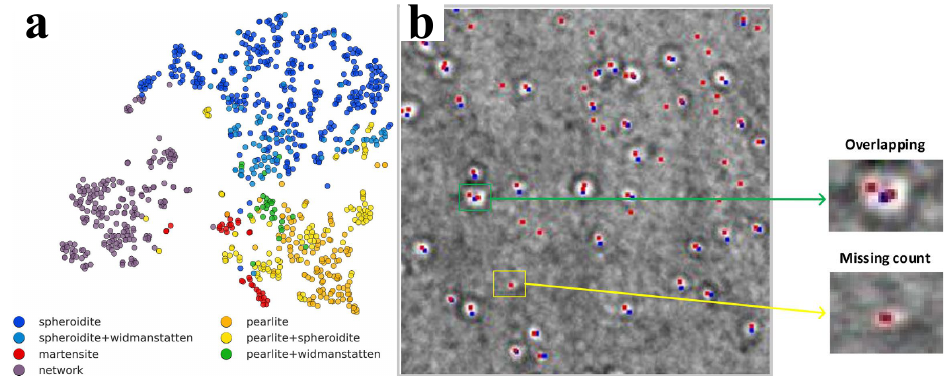
Figure 3. Microscopy and machine learning for identifying defects strongly related to mechanical properties. ( a ) The map of t-distributed stochastic neighborhood embedding (t-SNE) for the entire ultrahigh carbon steel dataset. Spheroidite, pearlite, etc. are various steel microstructure constituents, the densities of which define steel mechanical properties and are commonly classified by human experts. Here, an automated approach can provide steels’ mechanical property estimates. The figure is reproduced after [11] with permissions from Elsevier. ( b ) The location of He bubbles in a TEM image of an irradiated Ni-based alloy marked manually by TEM analysis experts (blue) and using the ML approach (red). Reproduced after [68] based on Creative Commons CC BY